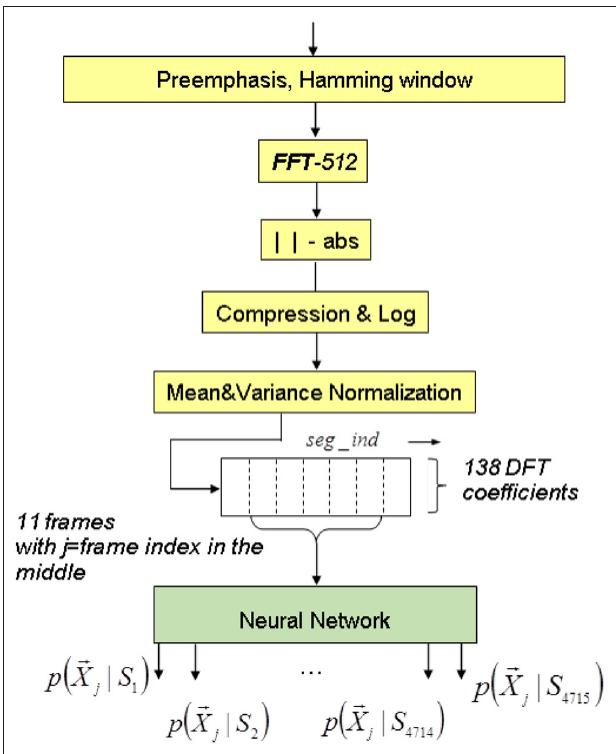
FIGURE 8 | Feature extraction and determination of emission probabilities with the DNN-HMM recognizer.